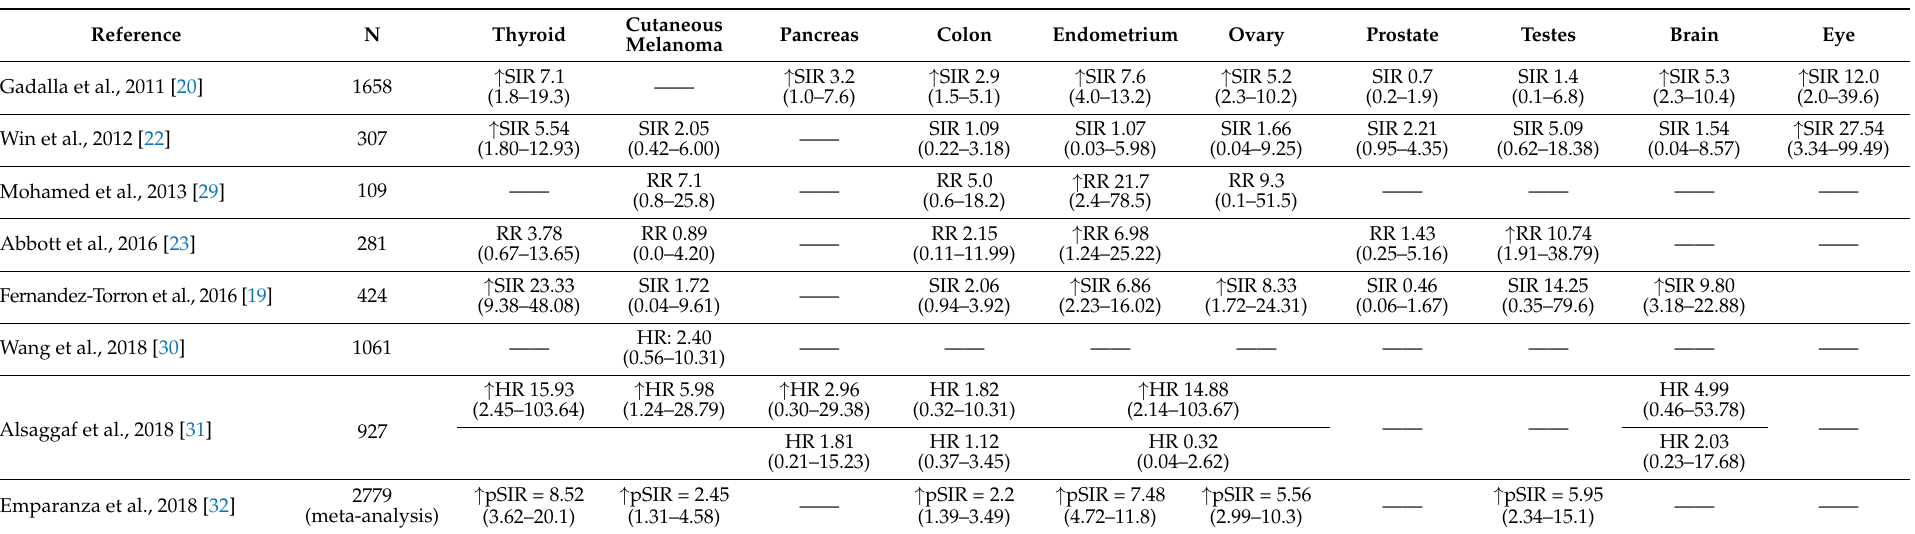
Table 2. More frequent types of cancers in DM1